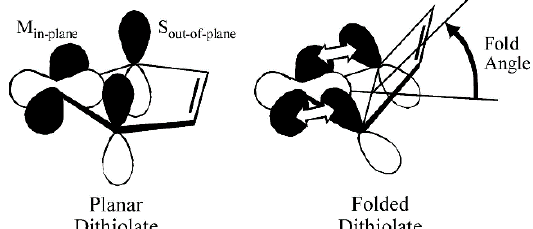
Figure 4. Fold angle distortions as a function of redox orbital electron occupancy in a series of Cp 2 M IV (bdt) complexes. (Adapted with permission from J. Am. Chem. Soc. 2018, 140, 14777–14788. Copyright (2018) American Chemical Society).